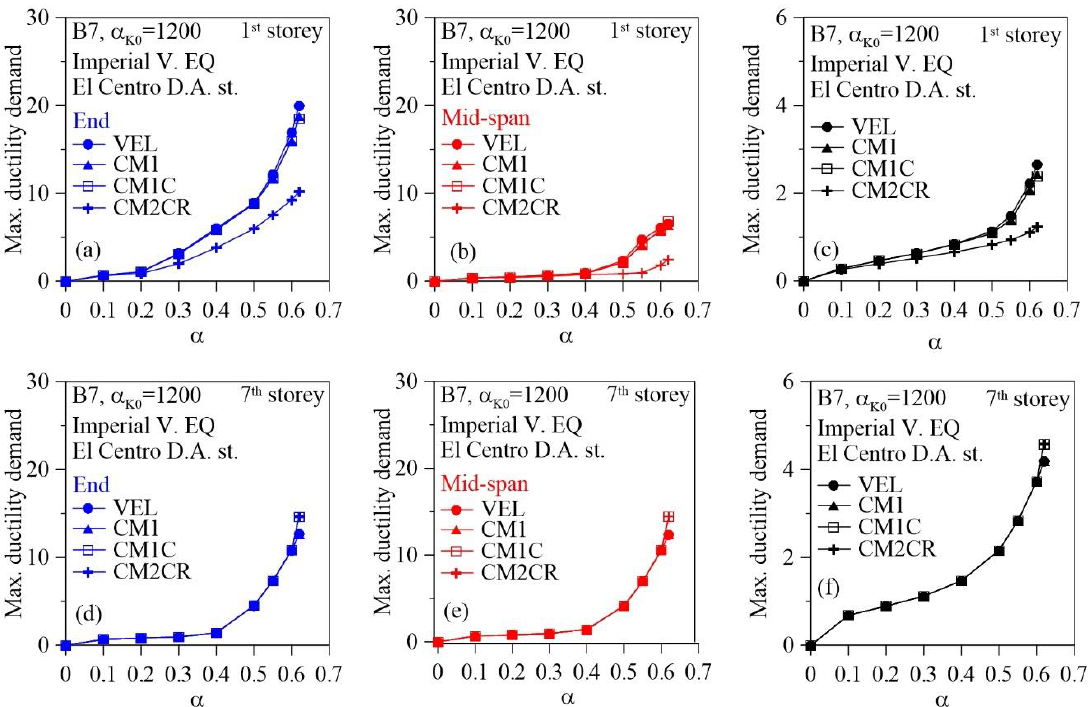
Figure 6. Ductility demands of the B7 structure subjected to the Imperial Valley EQ: end sections ( a , d ) and mid-span sections ( b , e ) of beams; end sections ( c , f ) of columns.